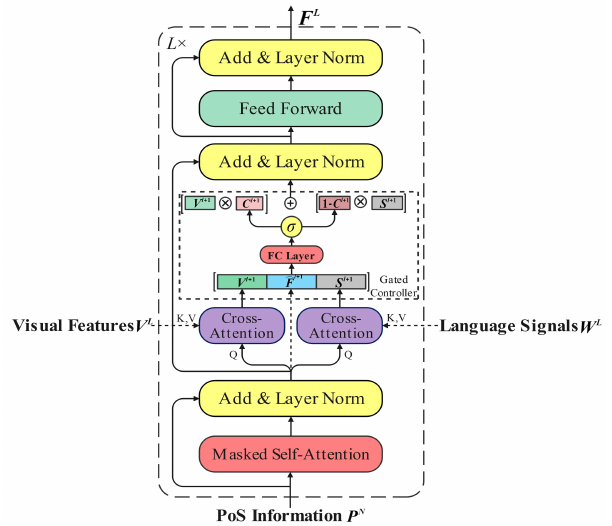
Figure 4. The structure of the dual attention based multimodal decoder model with part-of-speech guidance. The multimodal representations are first learned based on the dual attention with PoS guidance. Then, the gated controller is introduced to adaptively measure the contribution of visual and language cues for predicting